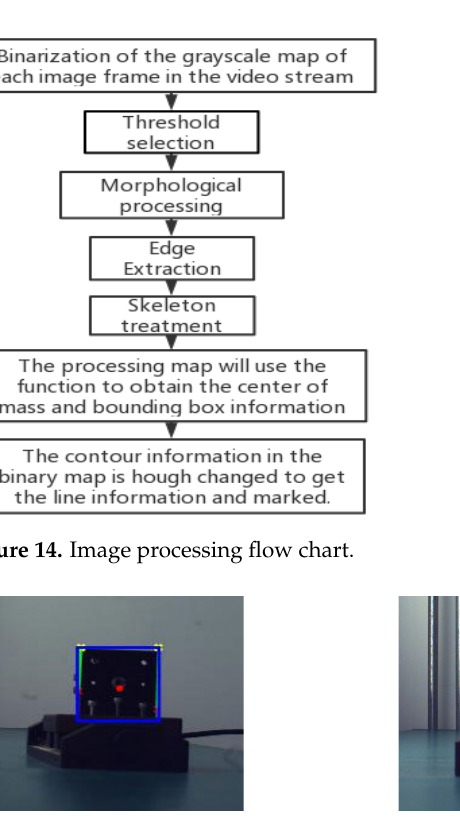
16 of 24 Figure 12. Left view of solid motion image acquisition. Figure 13. Right view of solid motion image acquisition. As a basic research area in the field of computer vision, object recognition tries to identify what objects exist in images and to report the position and orientation of these objects in the images [22]. After the image acquisition is completed, the coordinates of the center-of-mass points of the target object are extracted from each frame of each group of